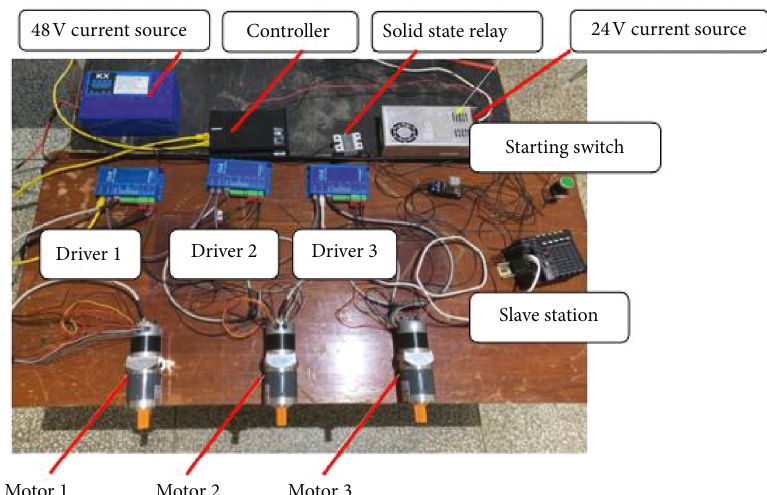
Figure 22: The single leg control